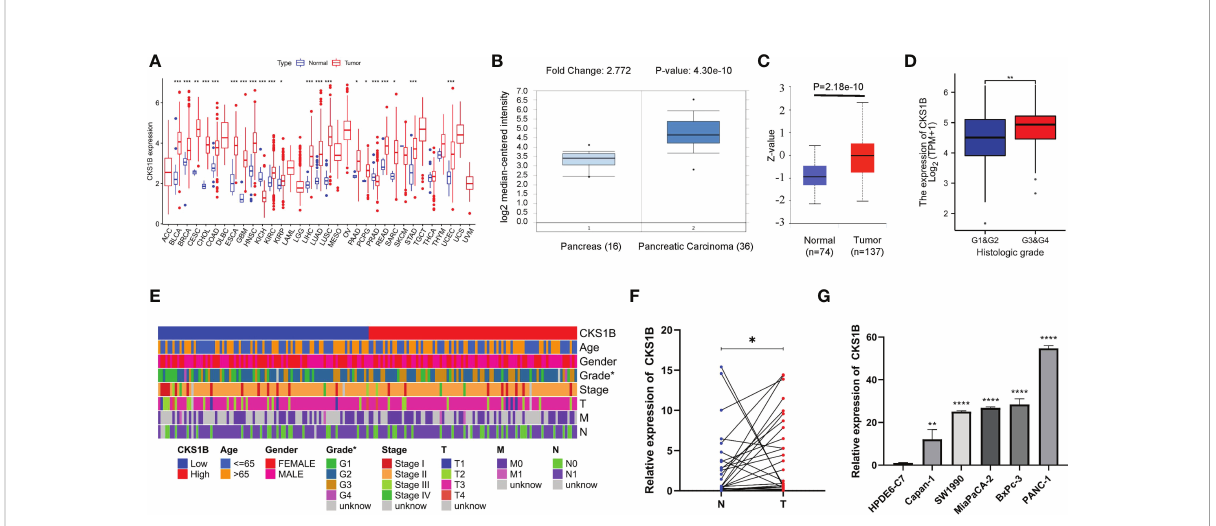
FIGURE 1 CKS1B is highly expressed and correlated with histological grade in pancreatic cancer. (A) CKS1B expression in different cancer types from TCGA datasets. (B) The mRNA expression of CKS1B in pancreatic cancer tissues in the Oncomine database. (C) The protein level of CKS1B in pancreatic cancer analyzed by the CPTAC database. (D) The clinical characteristics difference between high CKS1B and low CKS1B group. (E) The expression of CKS1B in different histological grade. (F) mRNA expression of CKS1B in pancreatic cancer tissues. (G) mRNA expression of CKS1B in cell lines. (*P < 0.05, **P < 0.01, ***P < 0.001, ****P <